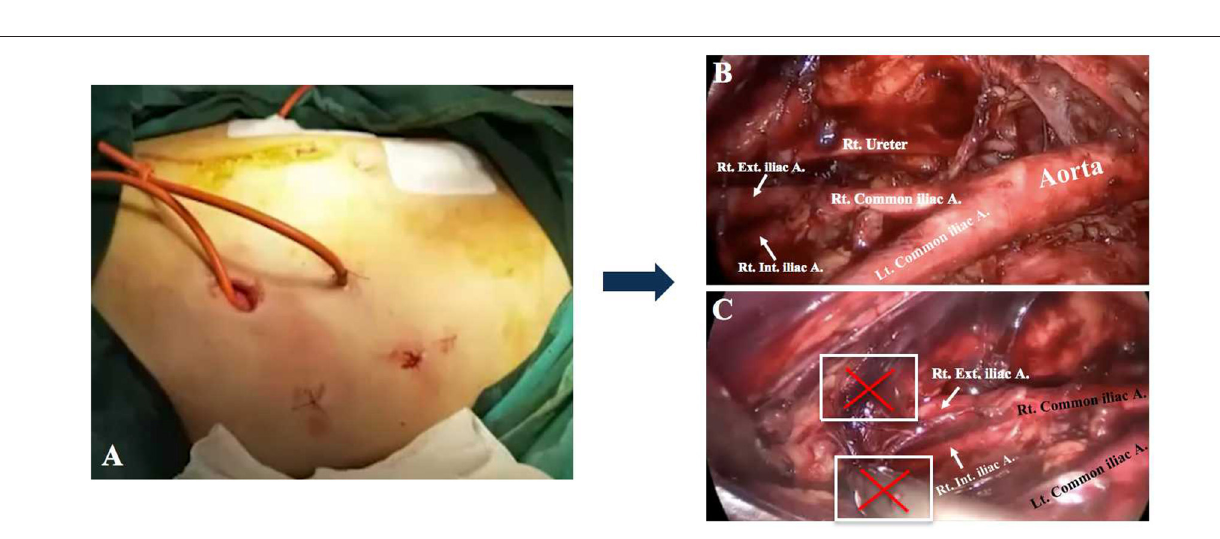
Frontiers in Surgery |